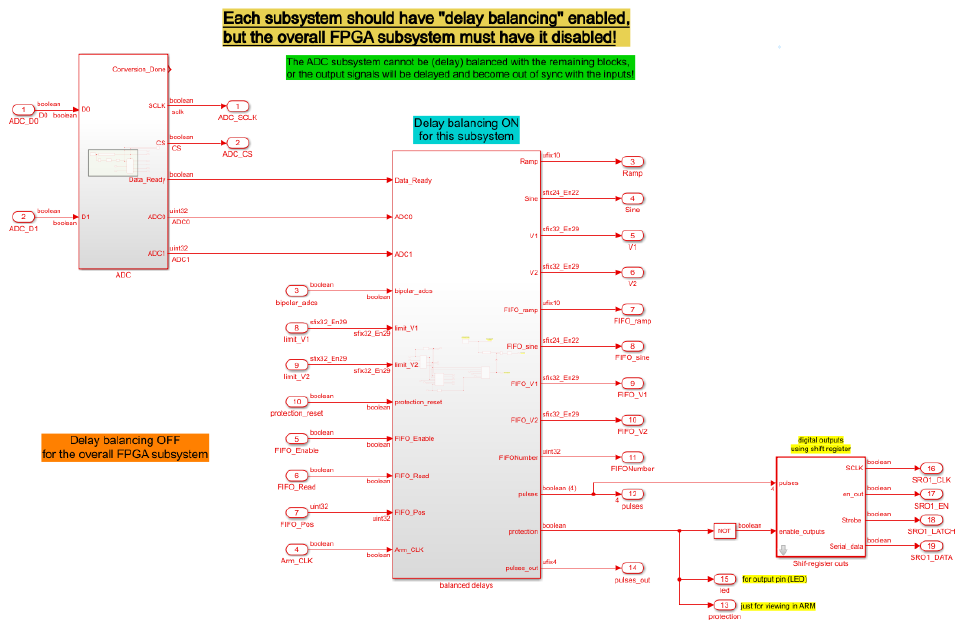
Figure 8. Internal view of the FPGA subsystem of demo model provided in [34]. Delay balancing can be enabled or disabled for a specific subsystem using the HDL Code → HDL Block Properties menu when right-clicking the